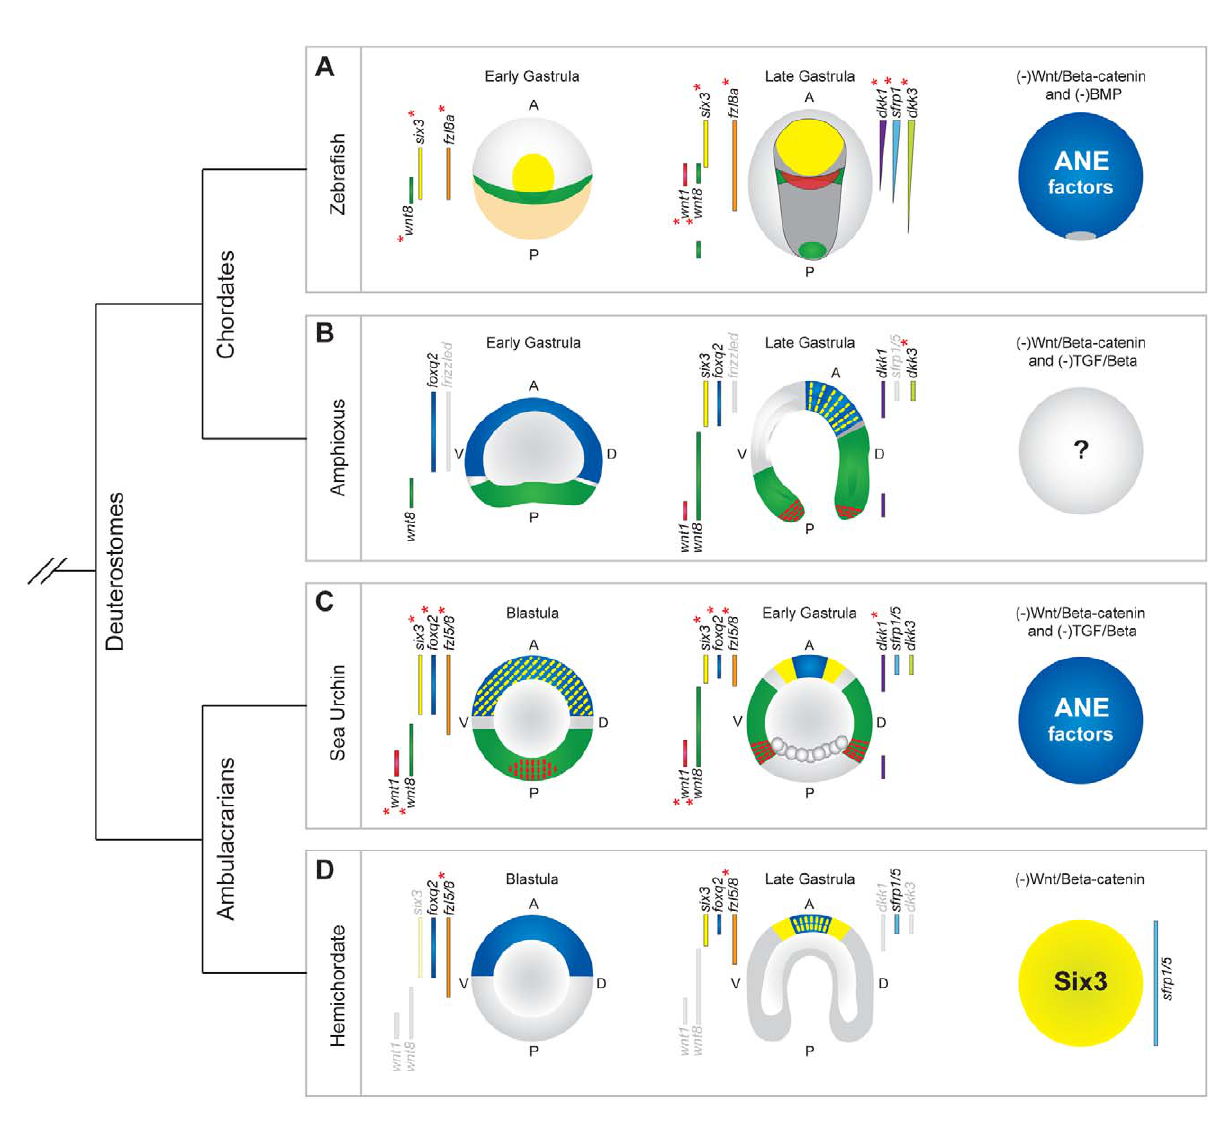
Figure 8. Conservation of expression patterns of orthologs of sea urchin genes that function in the development of ANE. The territorial expression of orthologs in each embryo is shown to the left and right of each diagram. In cases where there is no information concerning the expression pattern of a particular ortholog, it is represented in light gray. Red asterisks designate that functional studies show these factors are involved in AP patterning of the presumptive neuroectoderm. The images of embryos are colored to indicate the expression patterns of foxq2 , six3 , wnt1 , and wnt8 . (A) ANE factors are initially expressed throughout the presumptive zebrafish neuroectoderm at late blastula/early gastrula stages (left-hand diagram). These ANE factors are progressively down-regulated in posterior regions of the presumptive neuroectoderm (dark gray) during gastrulation by a mechanism involving Fzl8a, Wnt8, Wnt1, and Dkk1, until they are confined to the anterior pole (middle diagram). Factors such as sFrp1 and Dkk3 subsequently pattern the forebrain. The right-hand diagram shows that, in the absence of Wnt/ b -catenin and BMP signaling, ANE factors are expressed throughout most of the embryo. Embryos are oriented with their dorsal sides facing up from the page. Data taken from [17,21,29,73–77]. (B) In amphioxus embryos, foxq2 is expressed throughout the anterior half, and wnt8 throughout the vegetal plate, of early gastrula embryos (left-hand diagram). By late gastrula, foxq2 and the putative ANE factors dkk1 , six3 , and dkk3 are expressed in the anterior-most ectoderm. wnt8 and wnt1 are expressed posterior to these putative ANE factors, consistent with a role in the restriction of foxq2 , six3 , and dkk3 expression to the anterior pole (middle diagram). Data taken from [78–82]. (C) Sea urchin embryo ANE factors are initially expressed throughout the presumptive ectoderm, and wnt1 and wnt8 are both expressed in the posterior half of blastula stage embryos (left-hand diagram). Then, ANE factors are progressively down-regulated from posterior ectoderm by a Wnt1, Wnt8, Fzl5/8, and Dkk1-dependent mechanism (middle diagram). In the absence of Wnt/ b -catenin and TGF- b signaling, the entire sea urchin embryo expresses ANE factors (right-hand diagram). Data taken from this study and [22,24]. (D) In blastula stage hemichordate embryos, foxq2 is expressed broadly in the anterior half of the embryo (data show that six3 and fzl5/8 also are expressed broadly by early gastrula stages) (left-hand diagram). By late blastula stages, putative ANE factors foxq2 , six3 , and sfrp1/5 are restricted to the anterior-most ectoderm, and functional data show that sfrp1/5 restriction involves Fzl5/8 (middle diagram). In the absence of Wnt/ b -catenin signaling the entire hemichordate embryo expresses putative ANE factors six3 and sfrp1/5 (right-hand diagram). Data taken from [2,19,83,84].